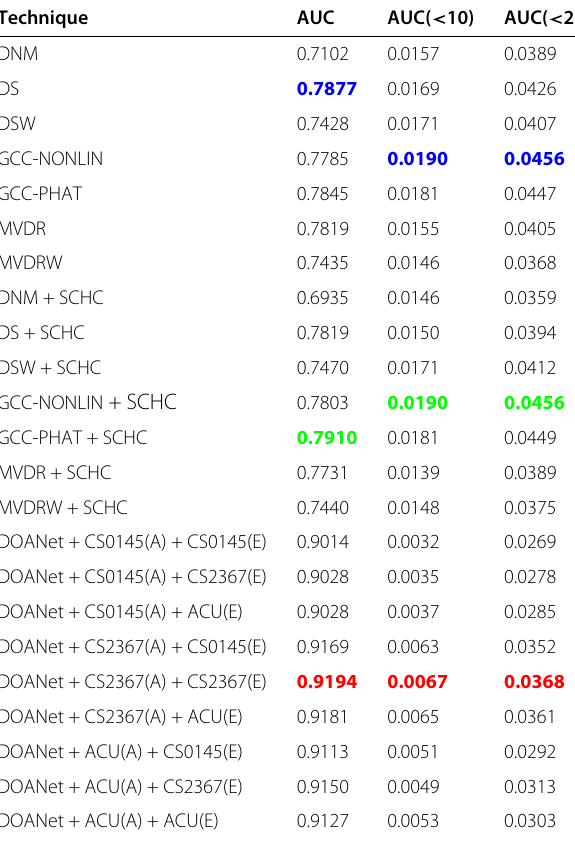
Table 6 AUC of static great-circle angular